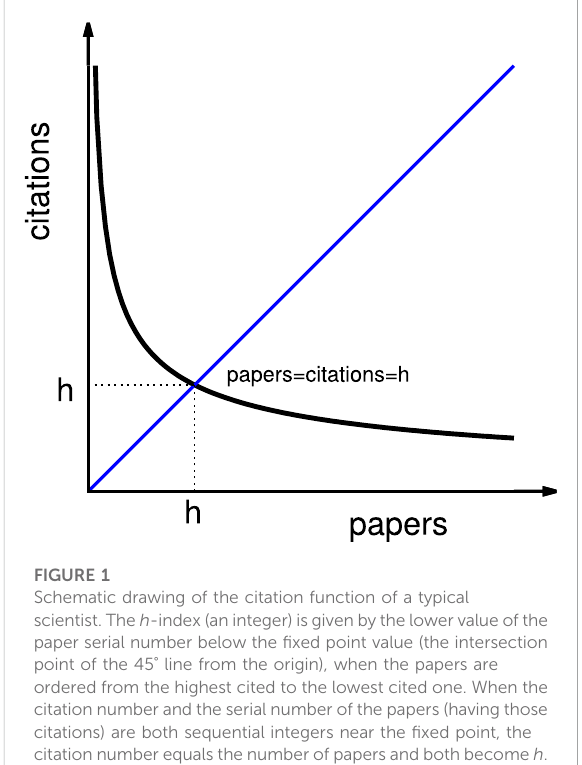
FIGURE 2 Finite size scaling analysis of the fi ber bundle model h − index (from avalanche size distribution). The scaling fi t to the Widom – Stauffer relations (Eq. 1) is obtained by making all the data points of different sizes ( N =1000,5000,10000, and 100000) andstresslevel(different σ values)collapsetogether.Itturnsoutthat the scaling form (Eq. 1b) with the exponent α =1 gives good data collapse. The inset shows that the data collapse clearly